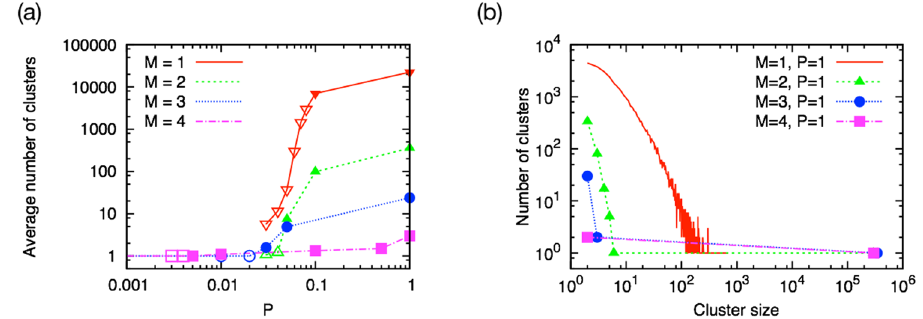
Figure 9. ( a ) Average number of clusters of the emergent systems at t = 9.5 × 10 6 . Except for the case of M = 1, The systems in the finite phase (open symbols) have single cluster, i.e., those are connected. The systems in the diverging phase (filled symbols) consist of multiple independent clusters. ( b ) Cluster size distributions of the systems with purely bidirectional interactions in the diverging phase, at the same time step ( t = 9.5 × 10 6 ). In the case of M = 1 (open reserve triangles), the distribution is continuous and broad up to the largest cluster size. Systems with M > 1 are composed of a single big cluster and some small